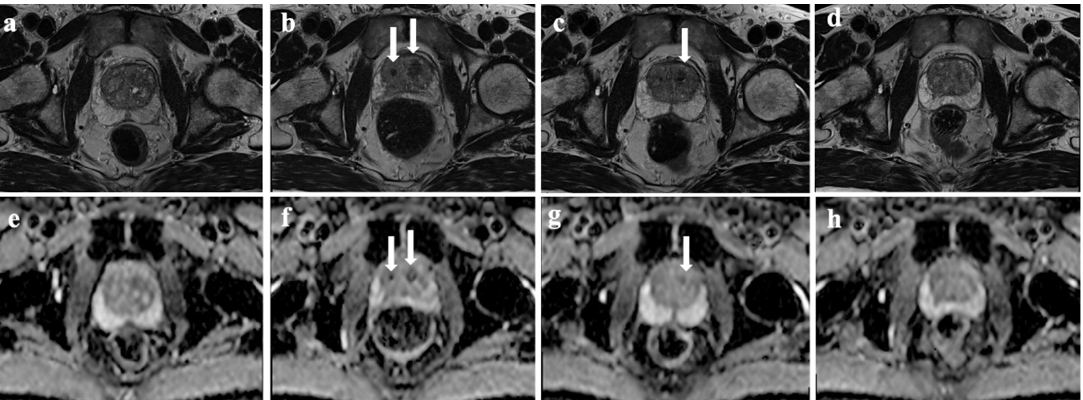
Figure 2. CG infarction. Prostate MRI of a 75-year-old patient with BPH. Axial T2w images and axial DWI of the prostate at baseline ( a , e ) and one, six, and 12 months ( b – d , f – h ) after PAE show bilateral infarct areas, which are most clearly delineated one month after embolization (arrows) and are increasingly minor manifested after six and 12 months